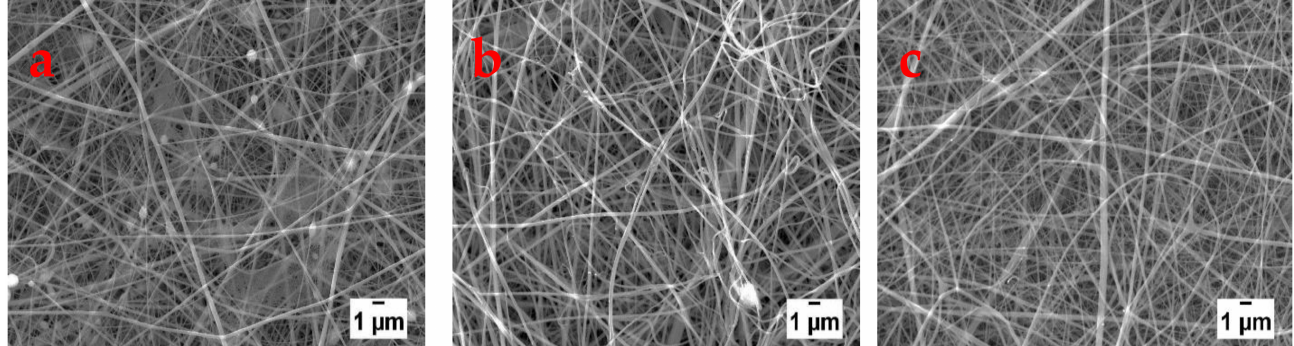
Figure 6. SEM images showing nanofibers produced from LiBr films at flow rates of ( a ) 4, ( b ) 6, and ( c ) 8 uL min − 1